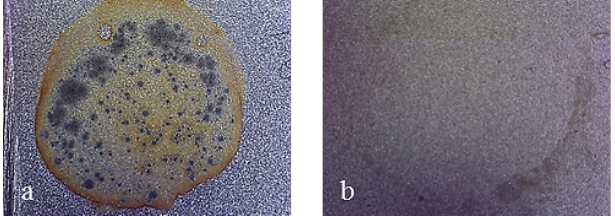
Figure 18. Working area after polarization on bare sandblasted finish: ( a ) X2NiCoMo18-8-5; ( b ) X105CrCoMo18-2.